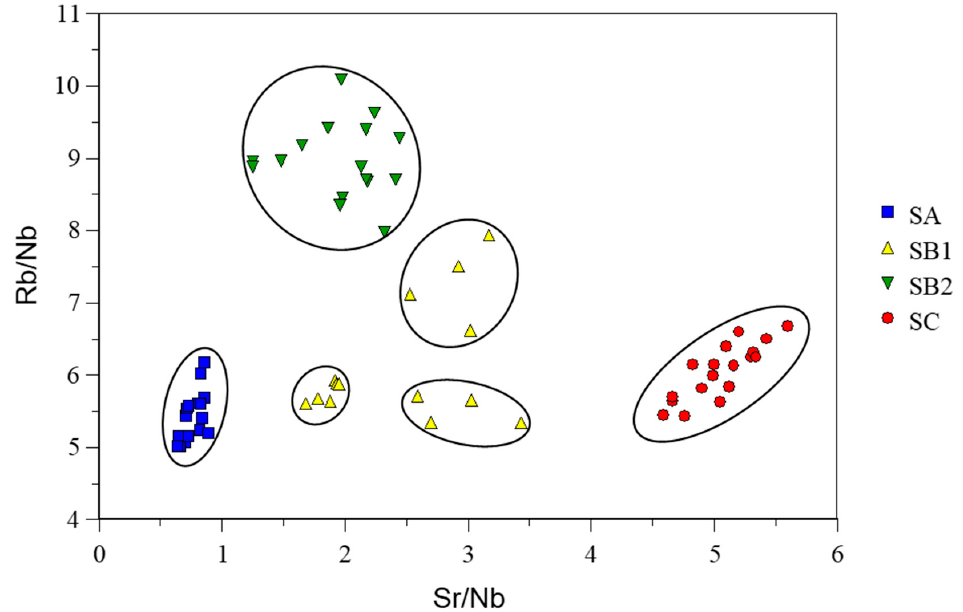
Figure 7. Separation of multiple subsources for Monte Arci (Sardinia) using a selection of geological samples collected by the author.